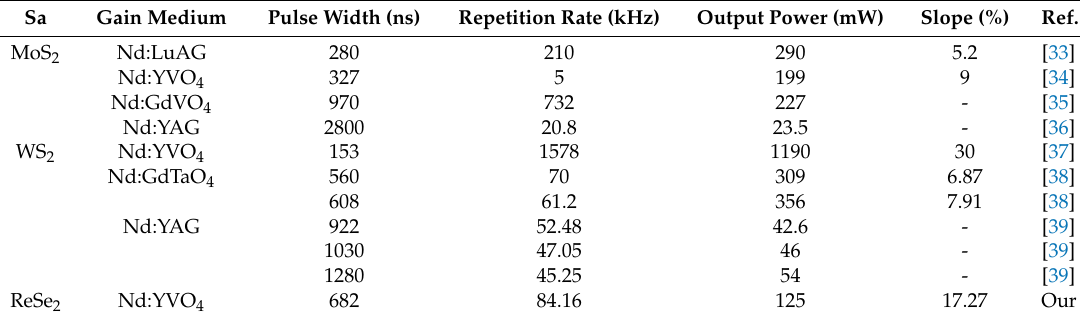
Table 1. Comparison of the passively Q-switched results in all-solid-state lasers based on transition metal dichalcogenides saturable absorber (TMDs